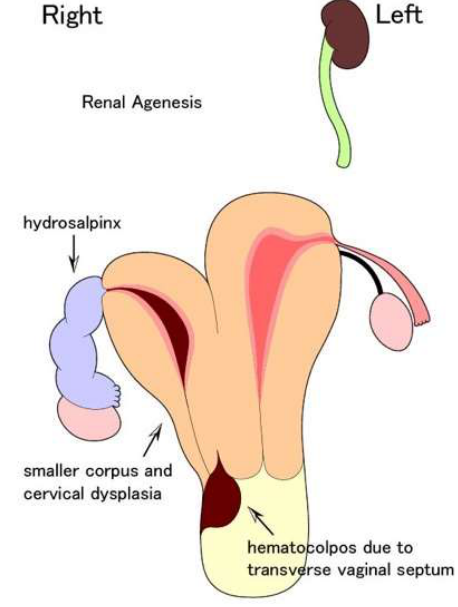
Figure 1. Schema of the double uterus, right hemivaginal obstruction, and right renal agenesis before vaginal septostomy at the age of 27.